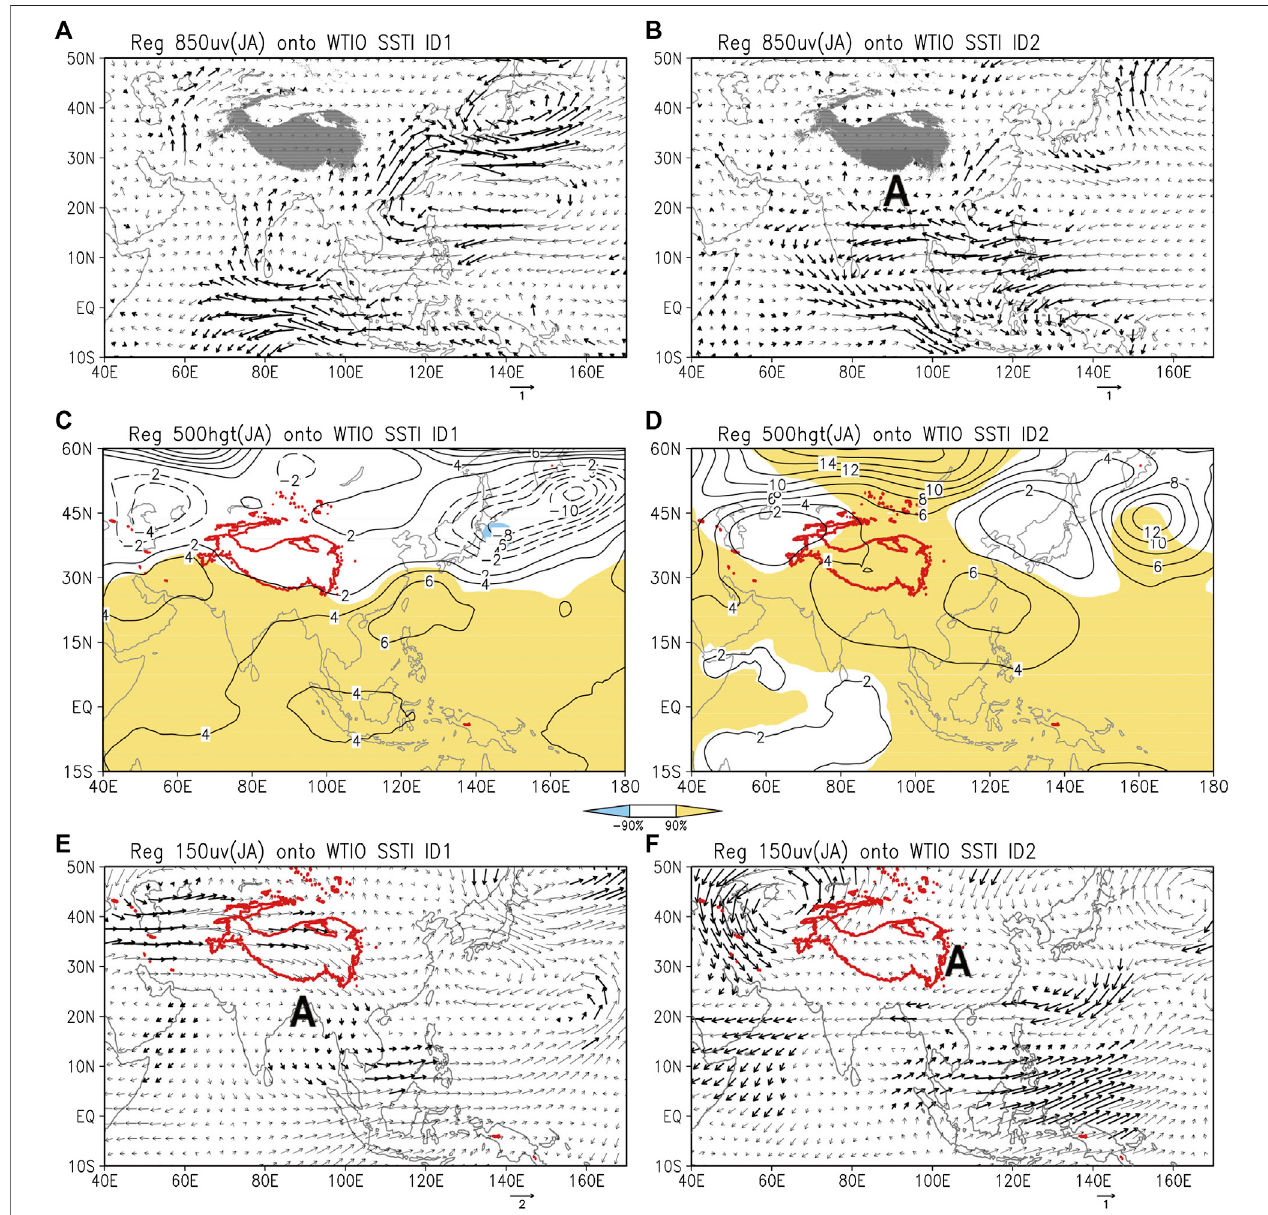
FIGURE 6 | Same as Figure 5 but for (A, B) 850hPa winds (vectors, m · s -1 ), (C, D) 500hPa geopotential heights (contours, 2 gpm) and (E, F) 150hPa winds (vectors, m · s -1 ) during (A, C, E) ID1 and (B, D, F) ID2. Thick vectors (A, B, E, F) and shadings (C, D) indicate areas that signi fi cant at 90% con fi dence level.